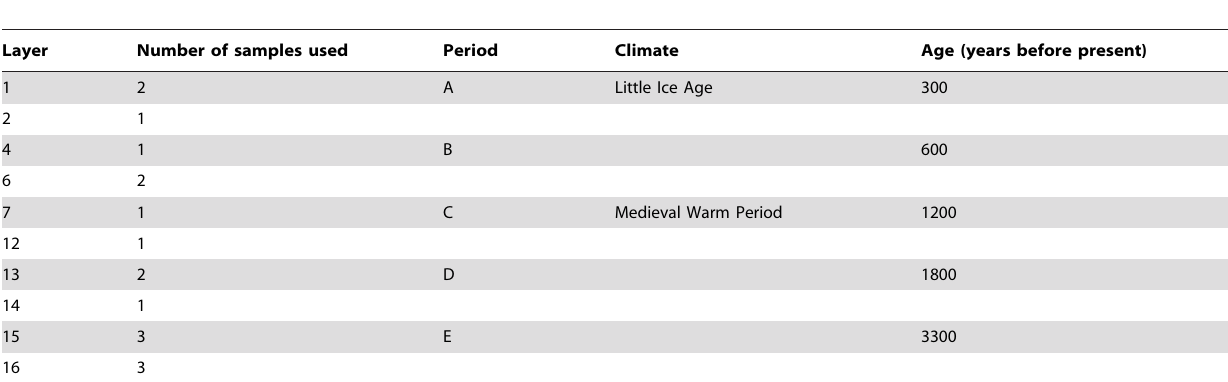
Table 1. Number of samples used in this study from each stratigraphic layer in Lamar Cave, and ages and the climatic periods represented by each